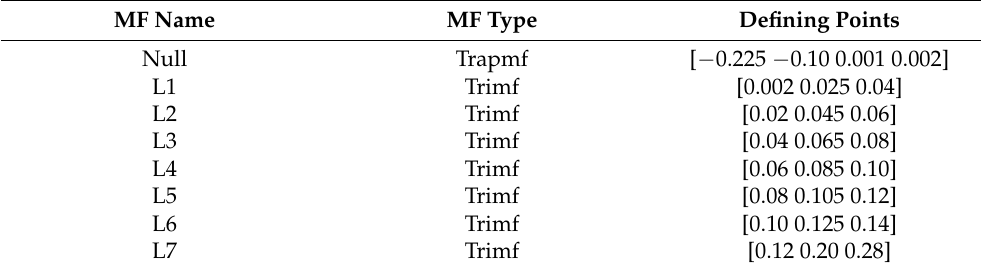
Table 4. Output (fuzzy logic controller pitch reference) membership functions